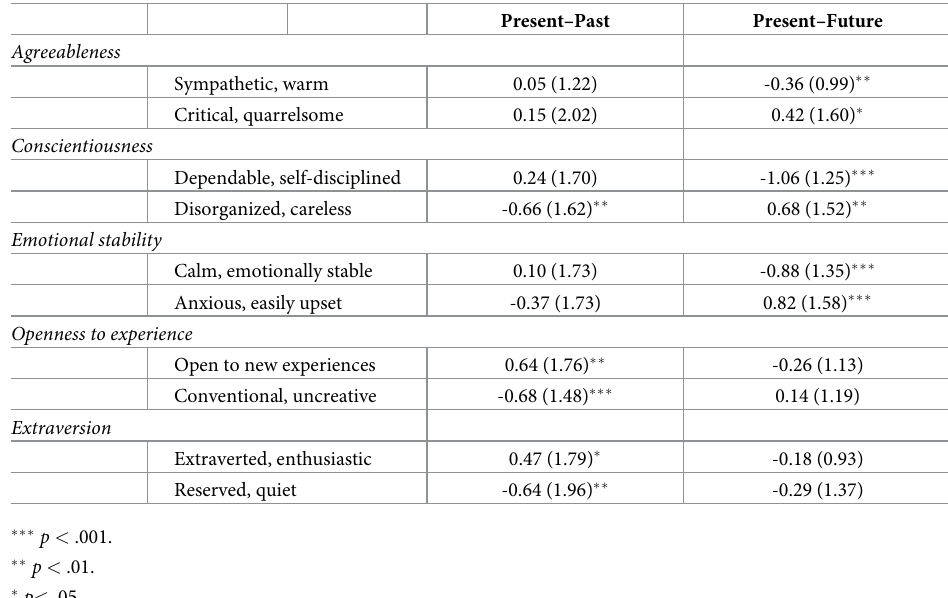
Table 1. Means (and standard deviations) of the difference scores between the ratings for the present minus the ratings for the past/future for five personality dimensions, with the significance test of the difference from 0 (one- sample t-test).